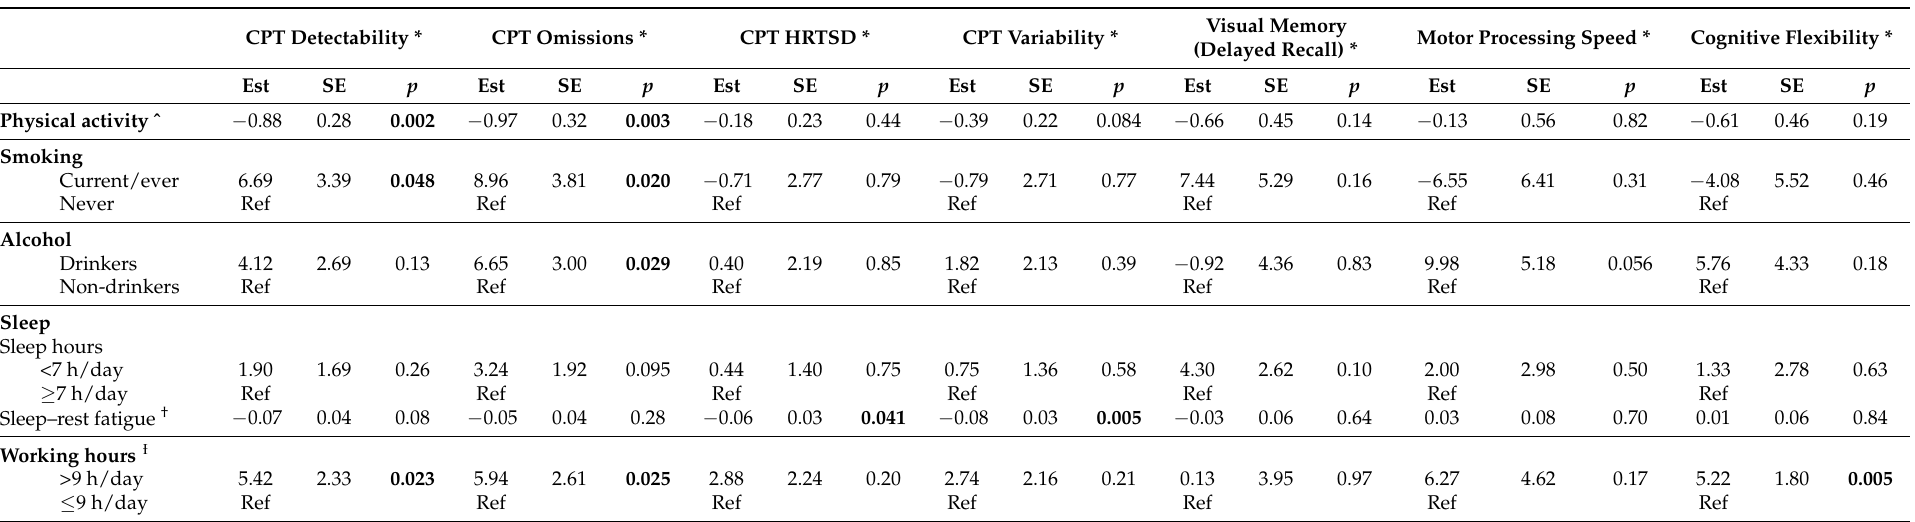
Table 4. Association between lifestyle factors and neurocognitive outcomes.